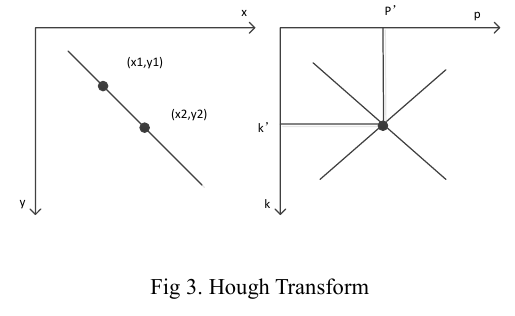
Fig 3. Hough Transform